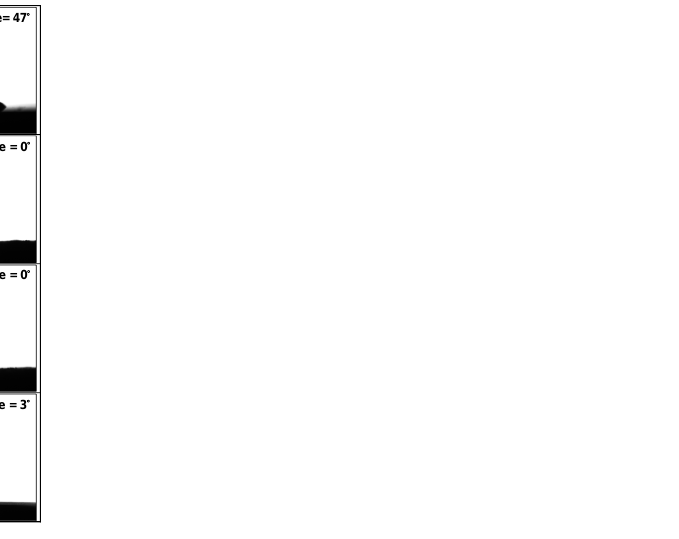
Figure 11. Photographs of deionized water droplets on Ti substrate and MAO coatings prepared with different applied voltages (applied current: 0.6 A, duration time: 5 min).